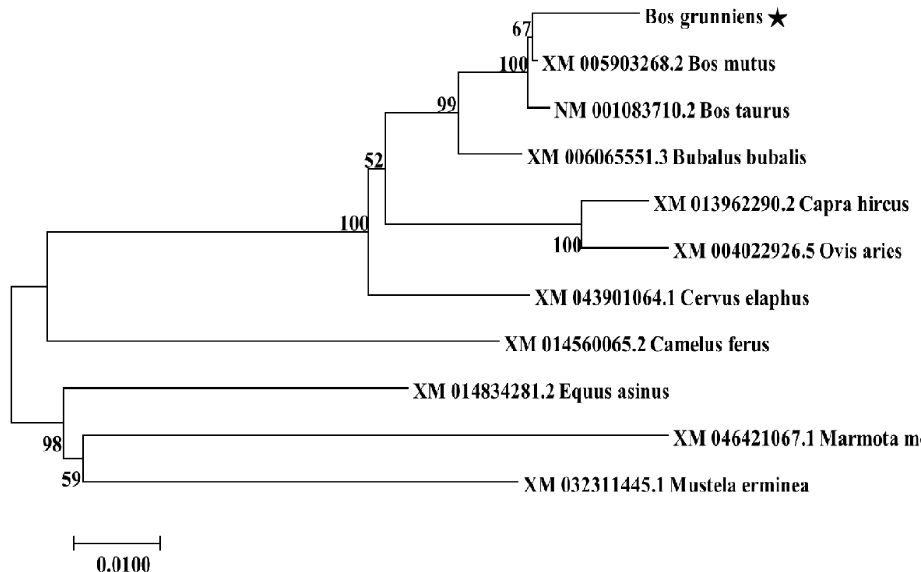
Figure 2. The phylogenetic tree of the TSSK1B gene established from the abovementioned align- ment. The asterisk “ ★ ” represents the TSSK1B sequence obtained from yak testis.